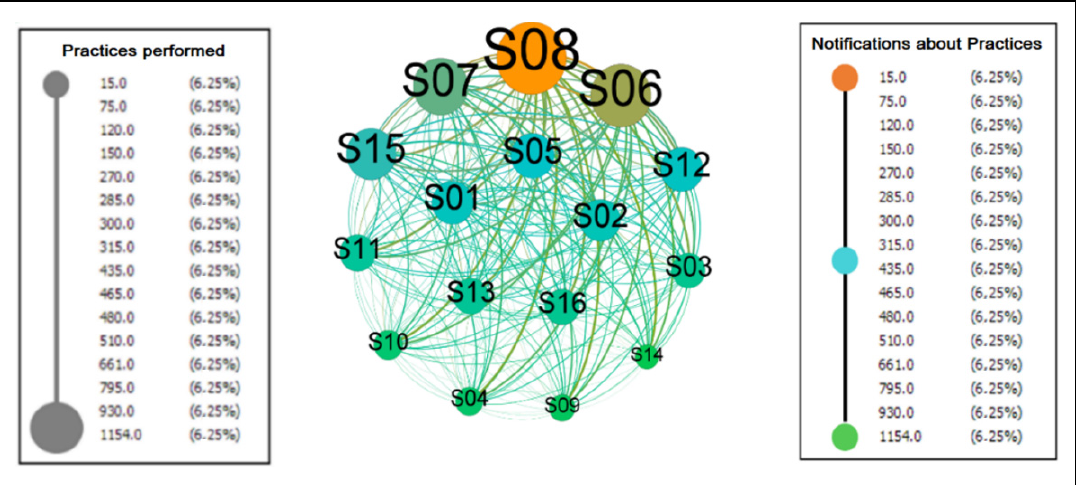
Figure 9. Messages between the HITS (authority and hub) pairs. Figure 10 represents the collaborative practices performed by the subjects within the platform.